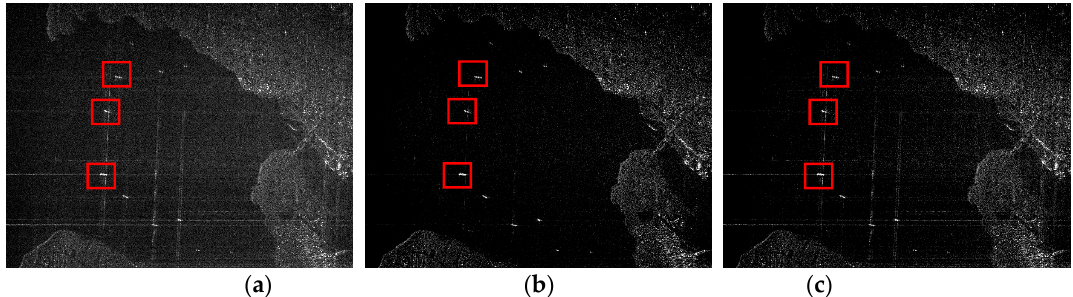
Figure 5. Images reconstructed from 80% down-sampled echo data by different methods. (Red squares indicate three ships.) ( a ) Matched filtering. ( b ) Raw data-based sparse imaging method. ( c ) Complex image-based sparse imaging method.